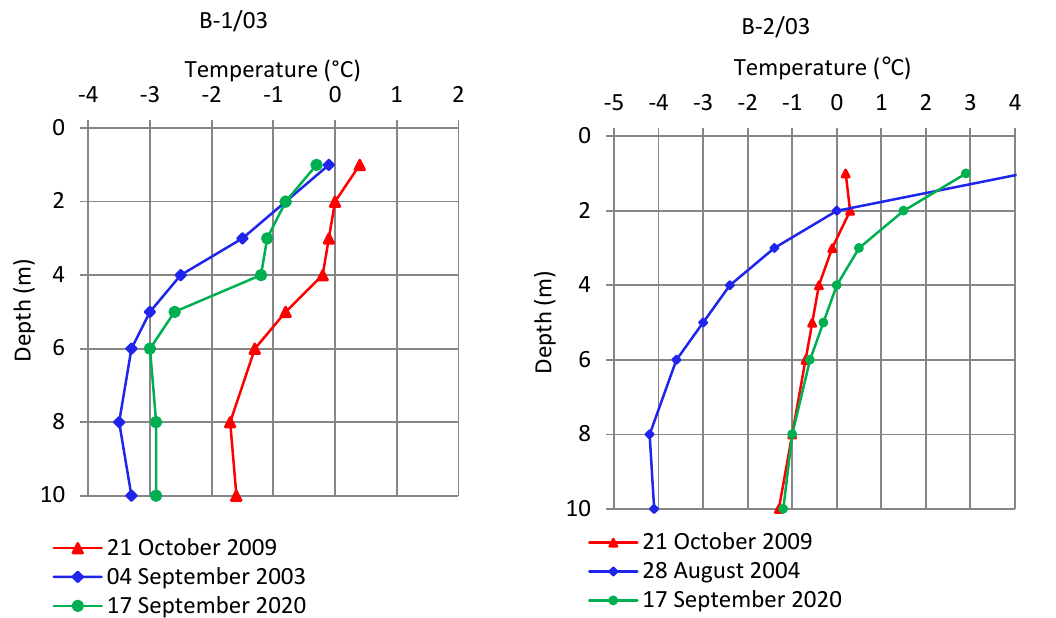
Figure 10. Maximum (2009, red), minimum (2003, blue), and 2020 values (green) of the ground temperature in the larch forest (b-1/03) and the burned/cleared site (b-2/03) in the inter-alas terrain type along the Mastakh–Yakutsk gas pipeline.